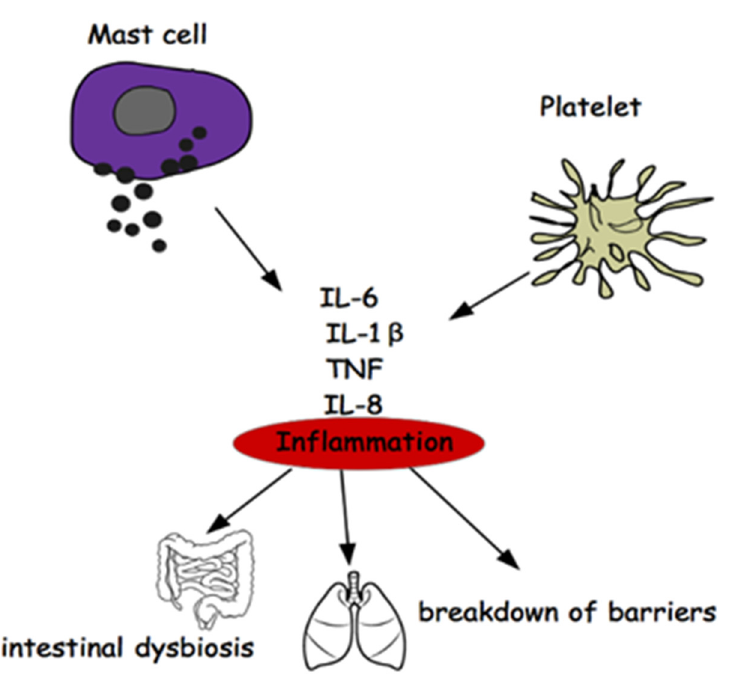
Figure 3. Relationship between Mast Cells, Platelets, Inflammation, Gut Microbiota.